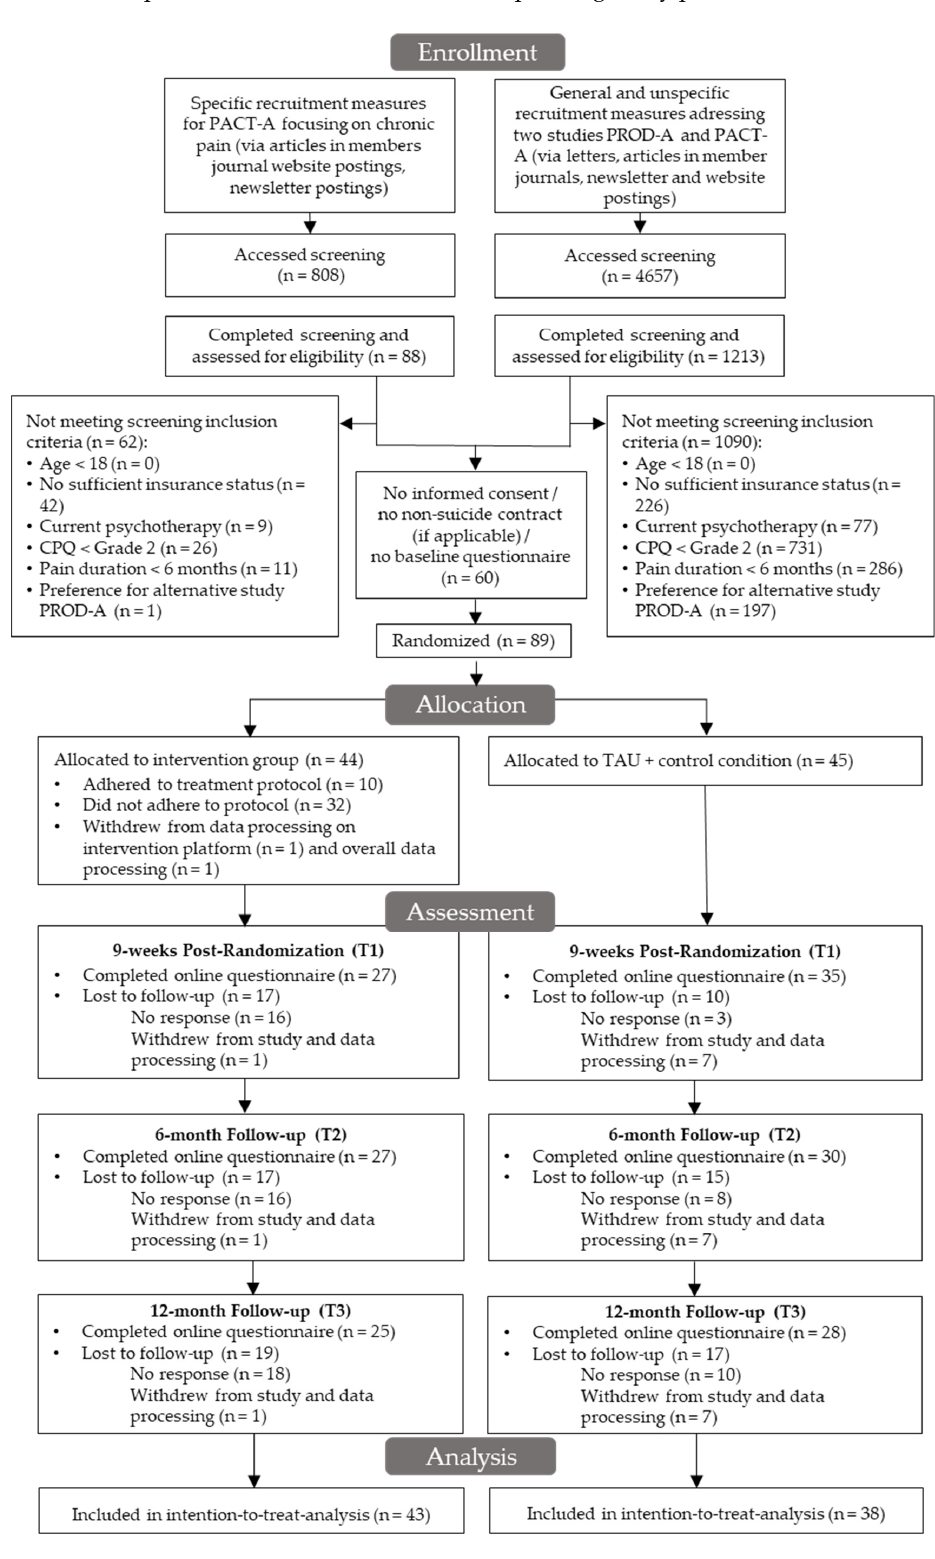
Figure 1. Study flow.